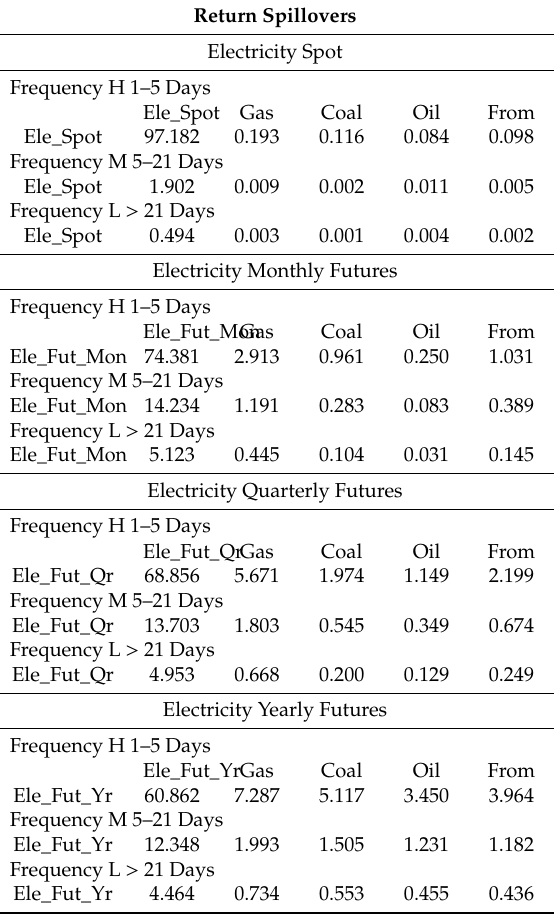
Table 6. The return spillover results of the Barunik–Krehlik methodology (2018).